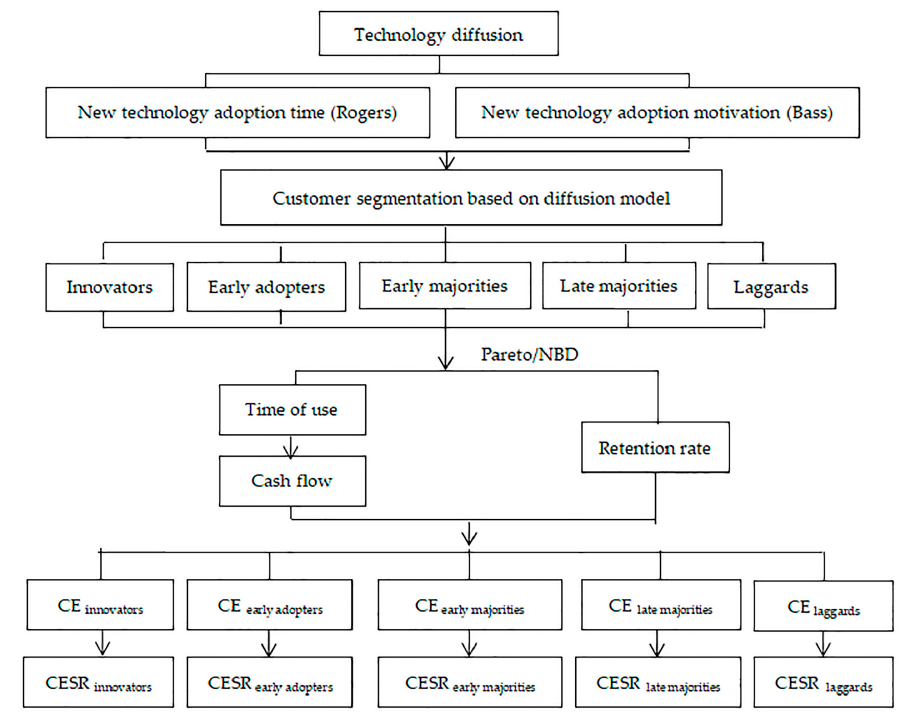
Figure 2. Research framework.